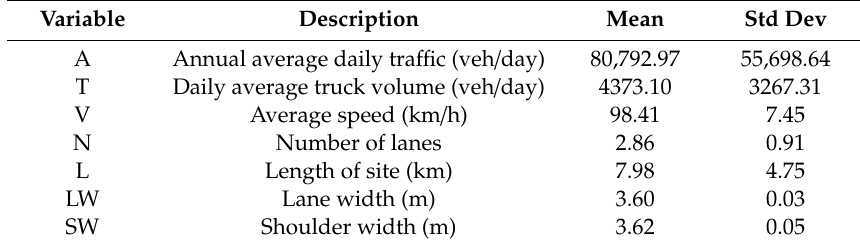
Table 2. Summary statistics of reference